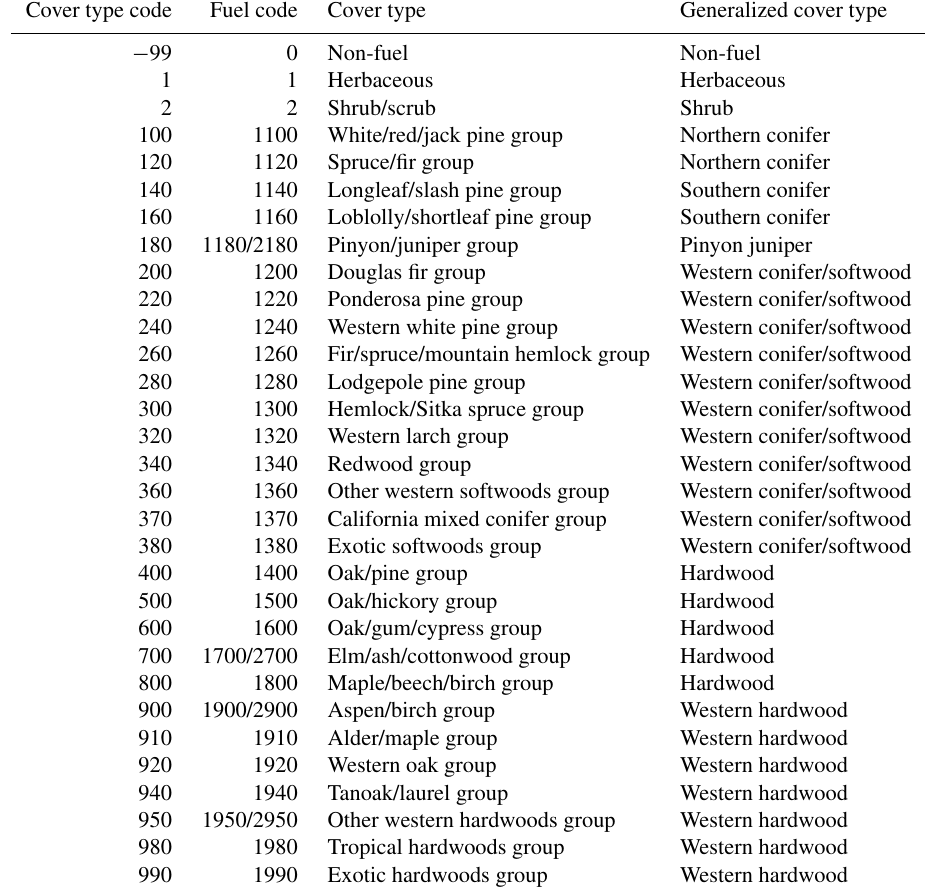
Table 1. MFLEI cover types and fuel